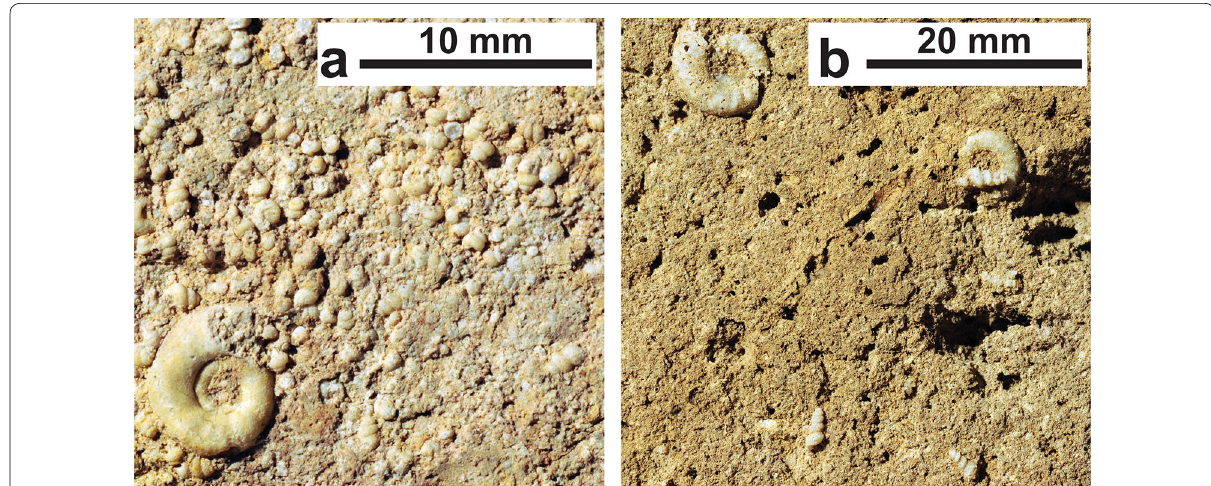
Fig. 5 Accumulations of small turriculate gastropods: larval-postlarval stages belonging to Caenogastropoda: a PIMUZ 37341 with a ceratitid ammonoid (lower left). Point 902/Mirigioli (Monte San Giorgio), Middle Besano Formation (bed 76); b PIMUZ 37340, three silicified gastropods (bottom and upper right) together with two silicified ceratitid ammonoids ( Repossia acutenodosa Rieber, 1973). Valle Stelle (Monte San Giorgio), Middle Besano Formation (bed